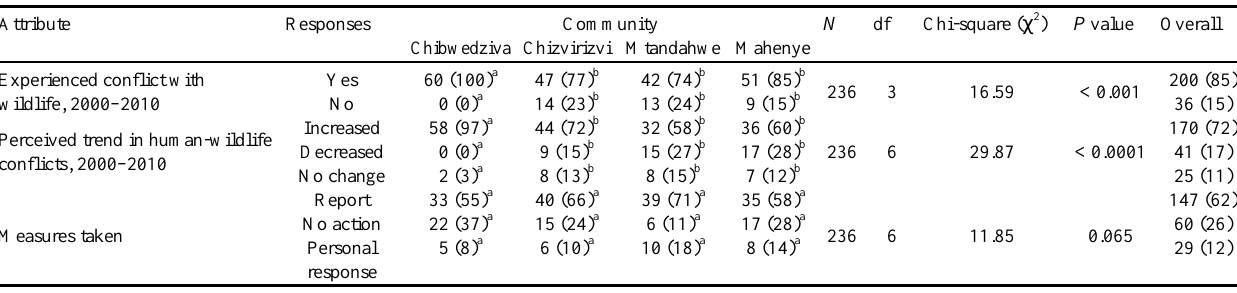
Table 4 . Differences and similarities in opinions regarding human-wildlife conflicts in communities adjacent to the northern Gonarezhou National Park, Zimbabwe. Values are number of respondents, and percentages in parentheses; N : sample size; df: degrees of freedom. Values with different superscript letters within rows differ significantly ( Z tests, P <